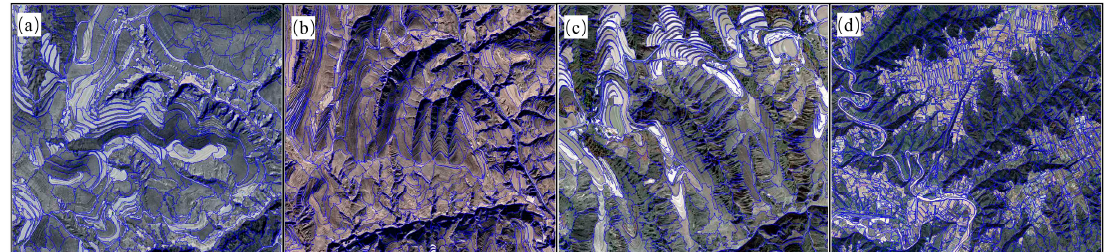
Figure 6. The local segmentation effect of the sample areas at the optimal segmentation scale. (a) segmentation effect of sample a with the scale of 36; (b) segmentation effect of sample b with the scale of 40; (c) segmentation effect of sample c with the scale of 32; (d) segmentation effect of sample d with the scale of 36.